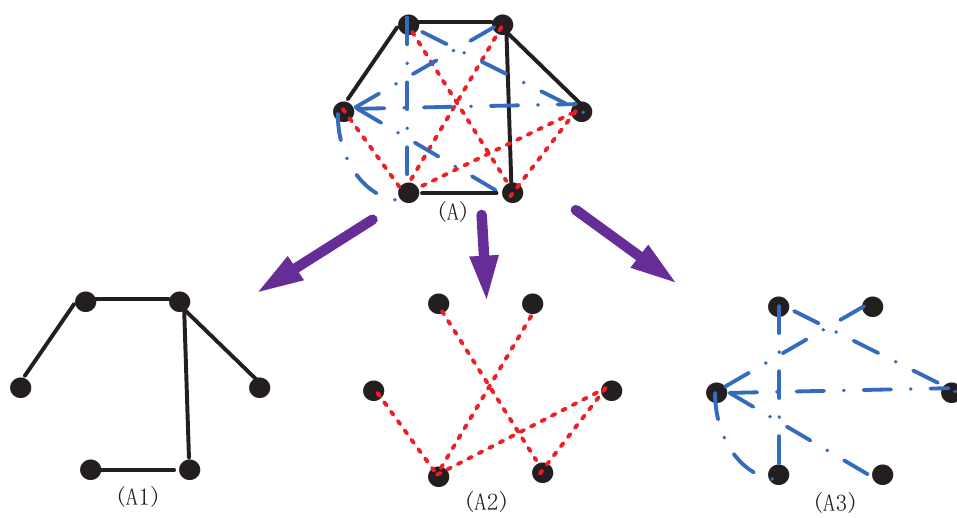
Figure 1. The schematic diagram of the logistic network: ( A ) complete logistic network; ( A1 ) highway network; ( A2 ) railway network; ( A3 ) air